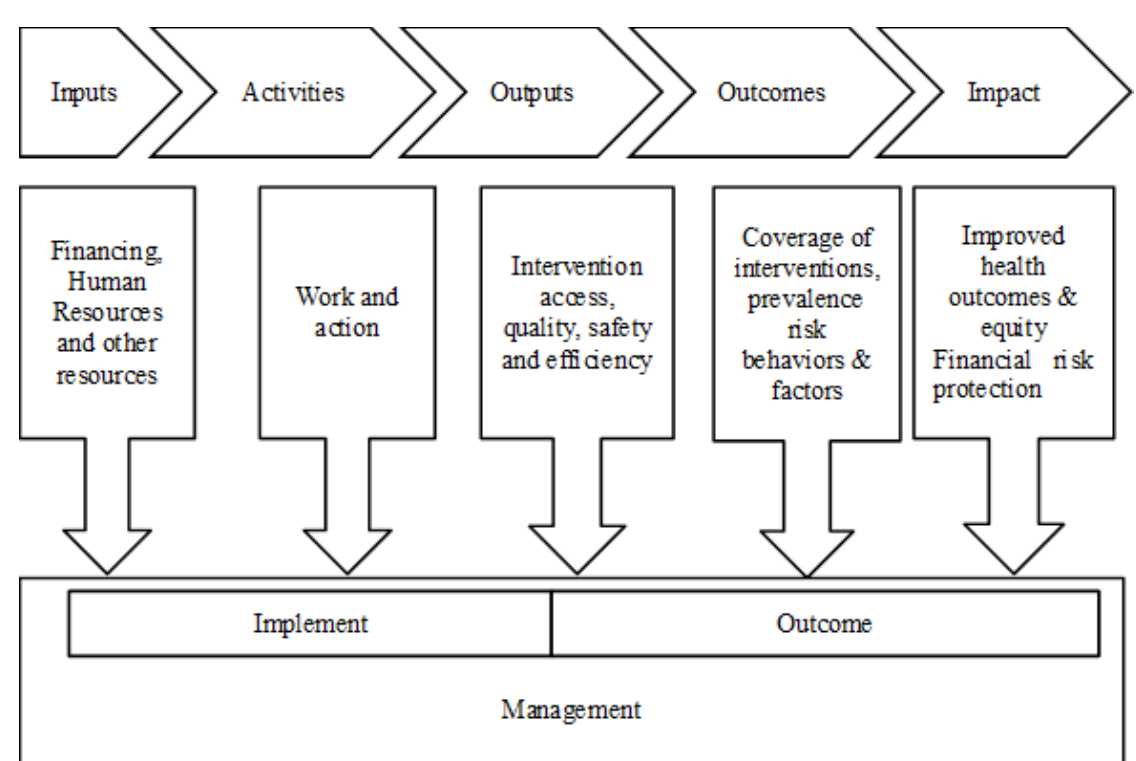
Figure 1. Logical frame of Results